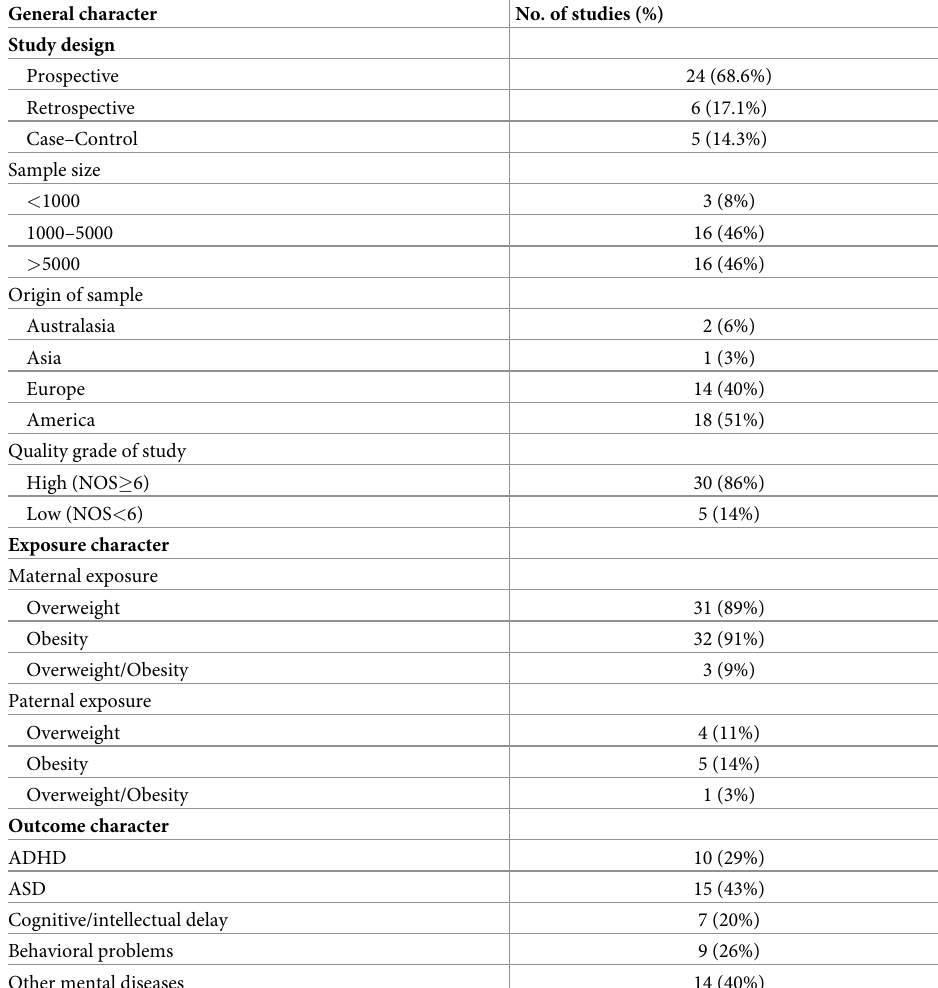
Table 1. Descriptive summary of the included 35